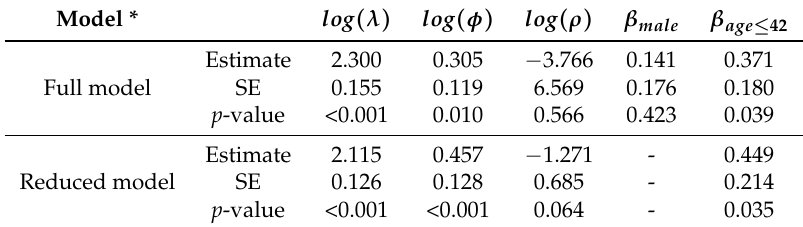
Table 1. Results of the analysis of COVID-19 under the generalized odds-rate class of regression models. Model * log ( λ ) log ( φ ) log ( ρ )